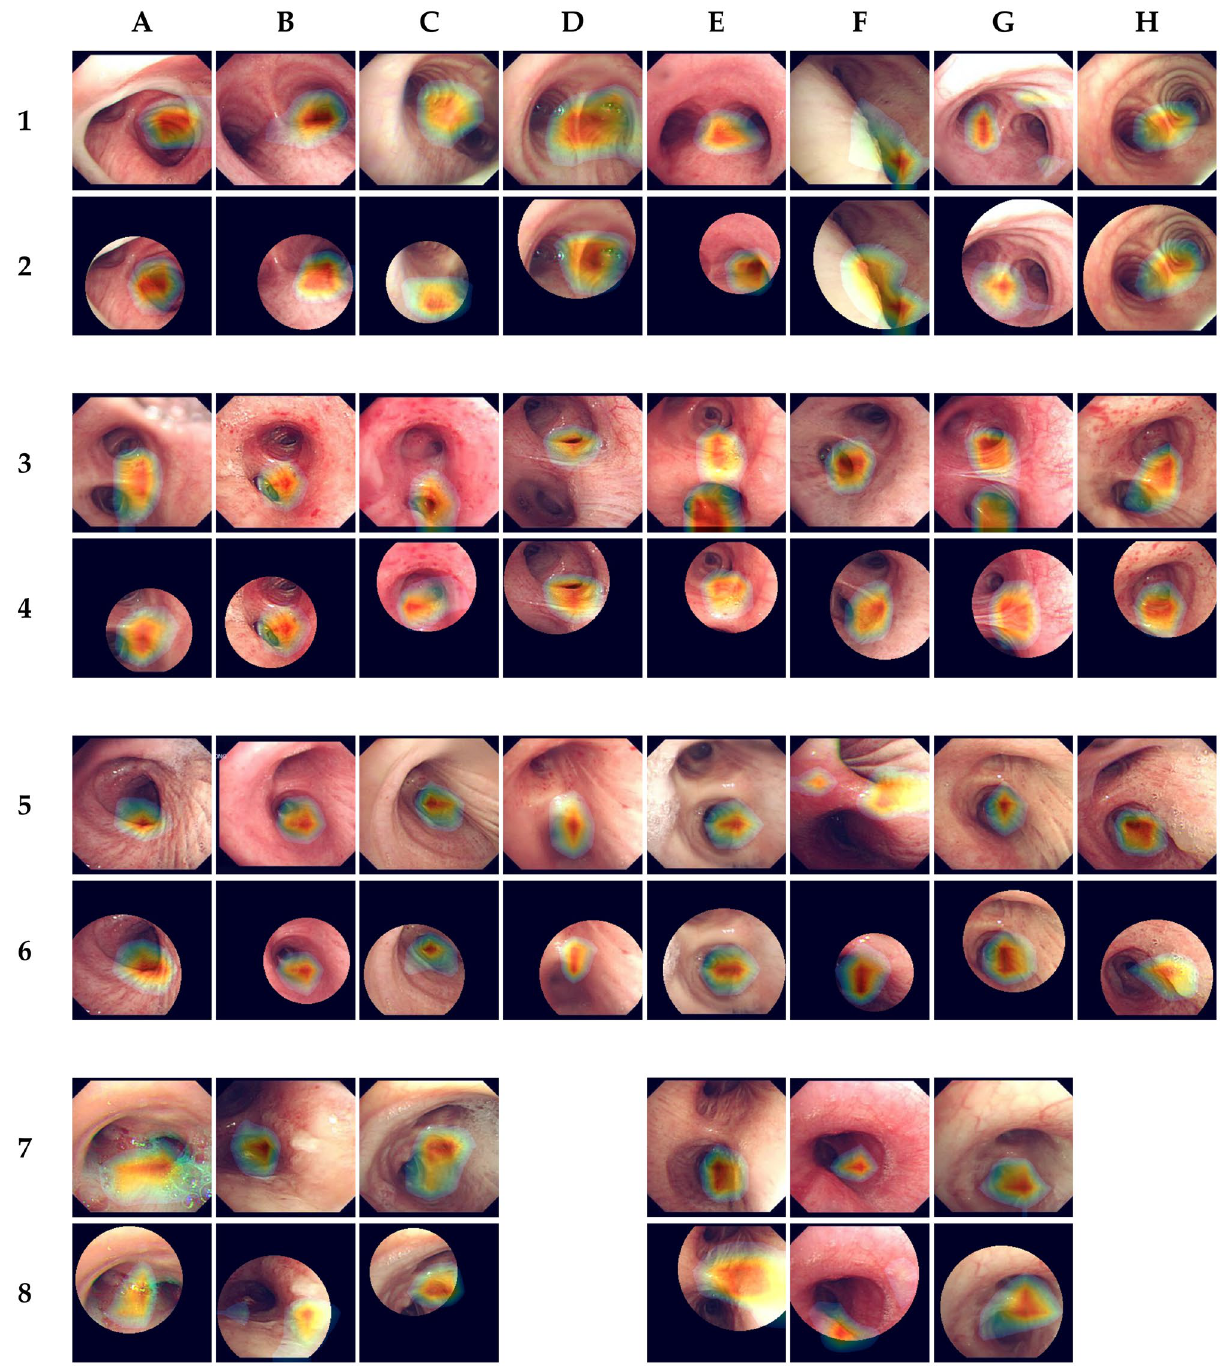
Figure 6. Saliency map generated by gradient-weighted class activation mapping. Odd lines and even lines represent matched original images and circular cropped images, respectively. Images at lines 1 and 2 are correctly predicted cases for the carina and those at lines 3 and 4 are for the left main bronchus. Lines 5 and 6 represent the correctly predicted images of the right main bronchus. Images at lines 7 and 8 indicate the cases in which inference has changed depending on whether the image is cropped. A7, true carina; A8, carina predicted as the right main bronchus; B7, true left main bronchus; B8, left main bronchus predicted as the carina; C7, true right main bronchus; C8, right main bronchus predicted as the left main bronchus; E7, carina predicted as the right main bronchus; E8, true carina; F7, left main bronchus predicted as the right main bronchus; F8, true left main bronchus; G7, right main bronchus predicted as the left main bronchus; G8, true right main